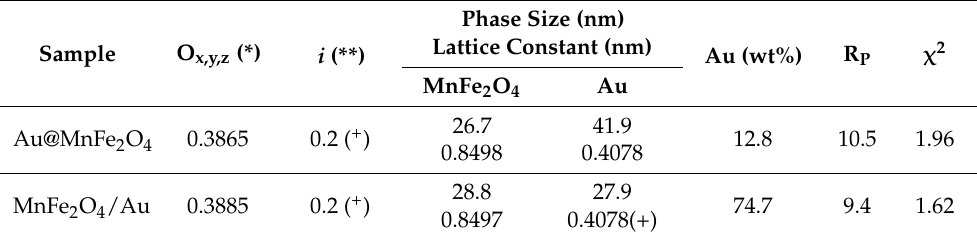
Table 3. Calculated R P and χ 2 parameters, phase sizes, and percentages obtained by Rietveld refine- (core/shell